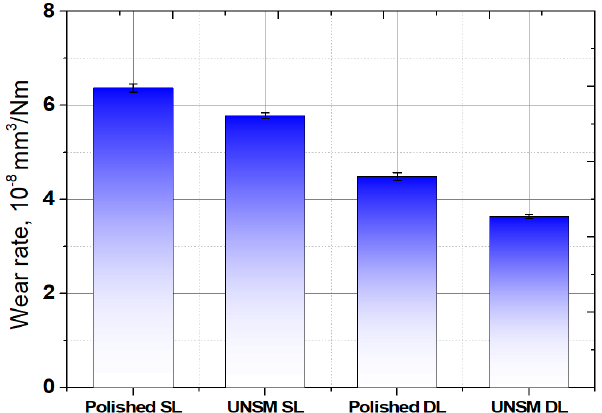
Figure 10. Wear rate results of the polished and UNSM-treated single and double layers.